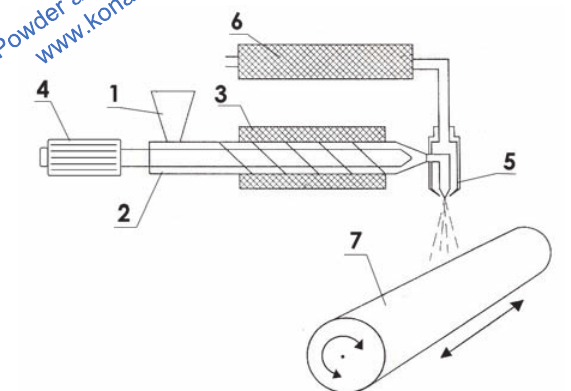
Fig. 1 System for production of melt-blown fibrous ma- terials.